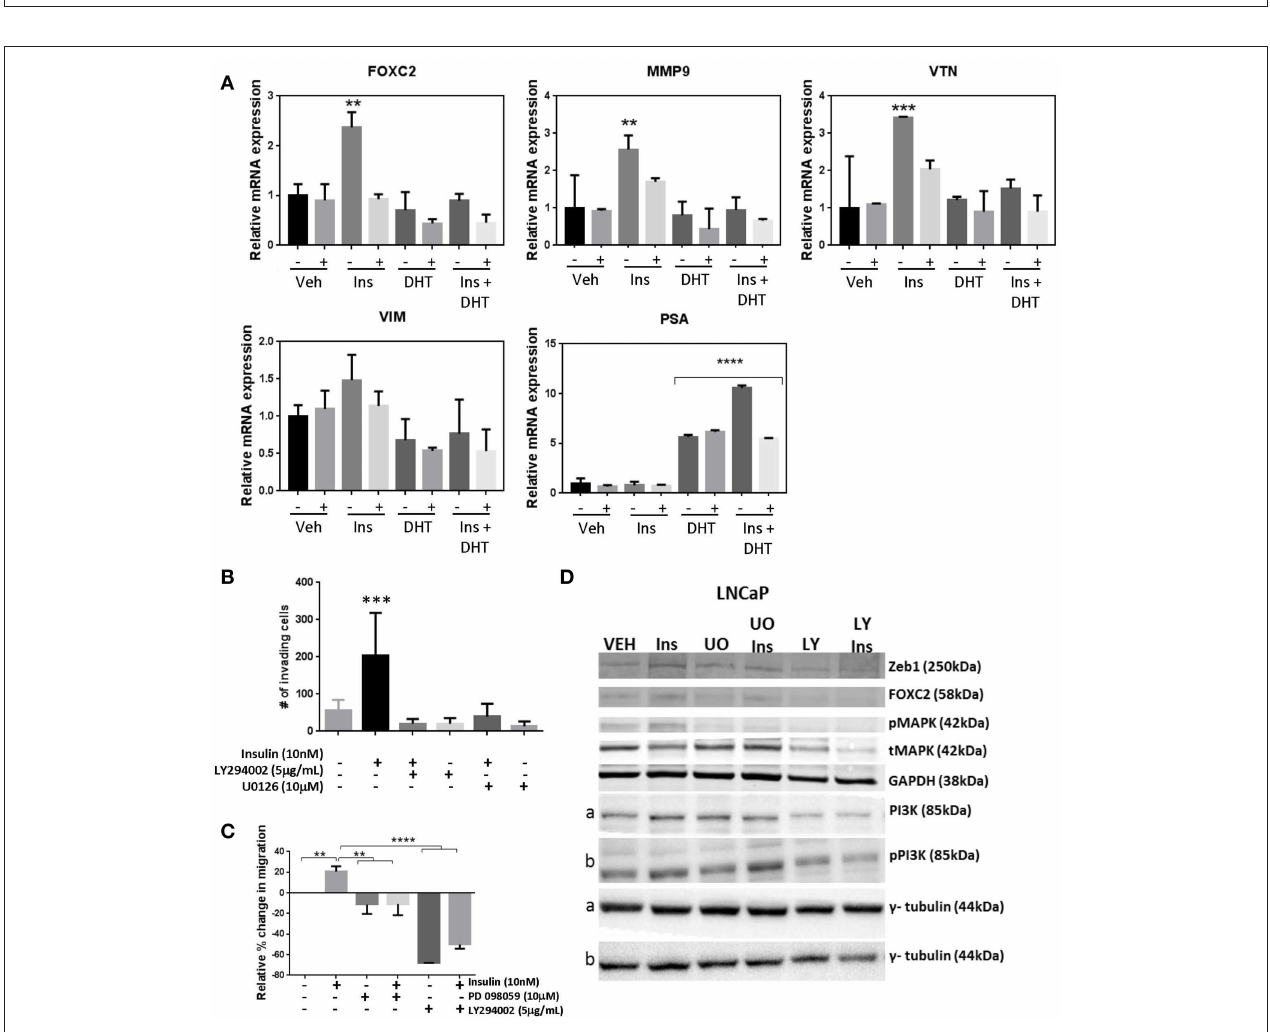
FIGURE 5 | mesenchymal markers VIM and VTN and (C) NE markers CHGA, NCAM and SST. (D) 22RV1 cells increased transcription factor expression and with (E) a muted rise in the mesenchymal transcripts with VTN significantly increased in 22RV1s and no significant change with insulin for VIM and MMP9. (F) NE markers CHGA, NCAM, and SST were significantly upregulated with insulin treatment. DUCAP cells replicated LNCaP transcription in response to AR inhibitor enzalutamide for both EMT and NE transcriptional factors, mesenchymal markers and NE markers (All graphs n = 3, * p < 0.05, ** p < 0.01, **** p < 0.0001, One-way ANOVA, ± SEM with vehicle as control).